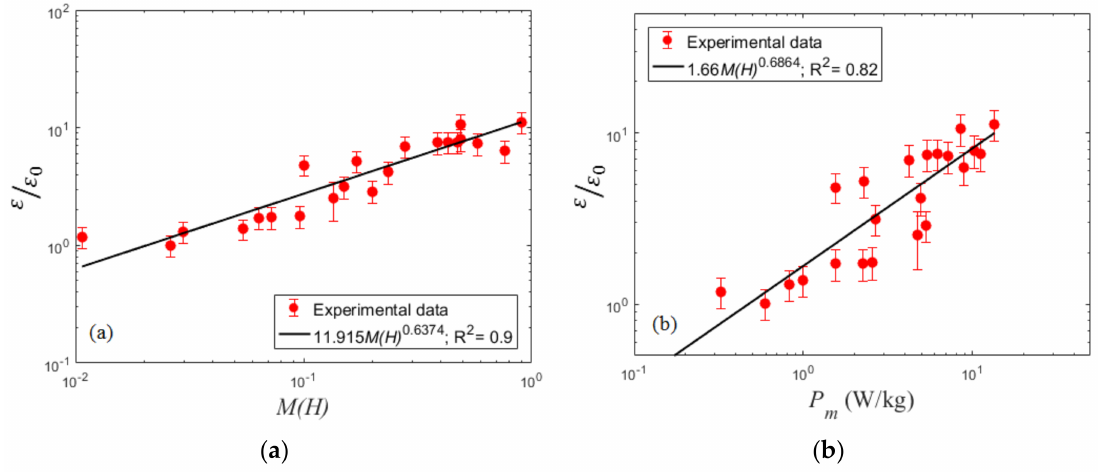
Figure 11. ( a ) void fraction versus M ( H ); ( b ) void fraction versus the specific power input ( P m ).